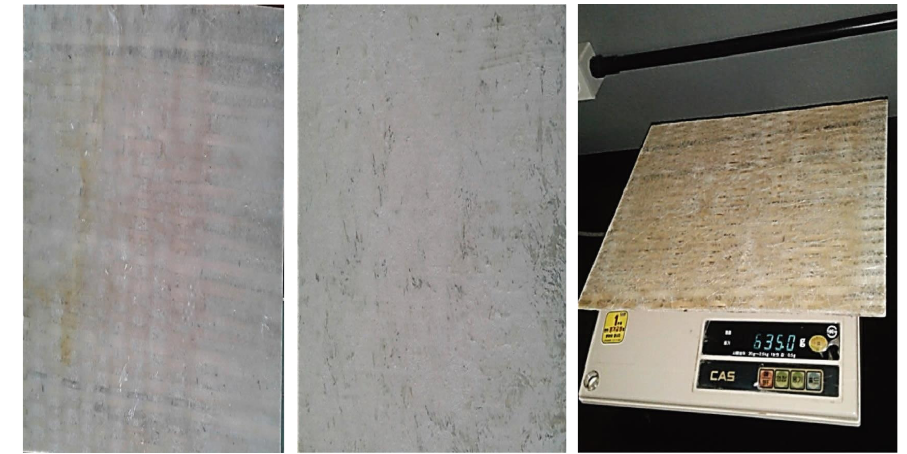
Figure 5: Te fnal prepared mold for specimen in both sides and measuring data.